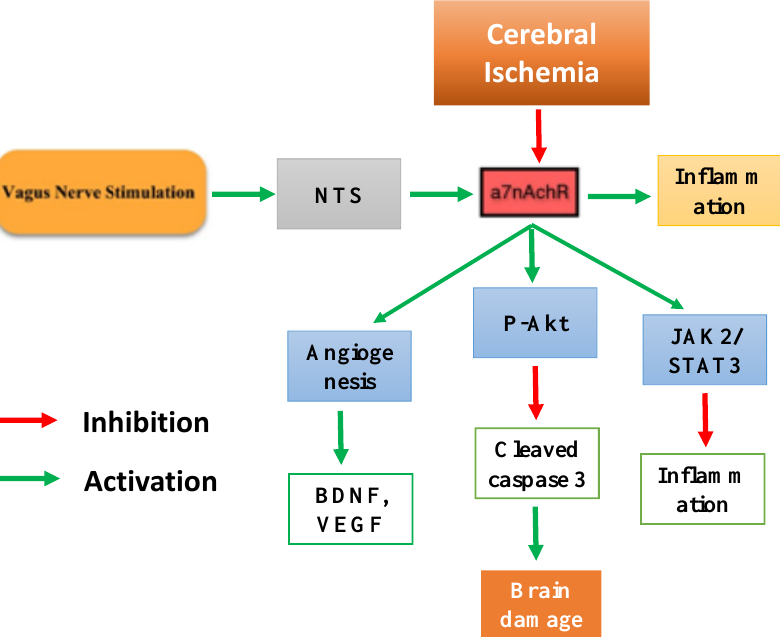
Figure 7. Vagus nerve stimulation has shown to improve stroke with various proposed mechanisms such as anti-apoptosis, angiogenesis and anti-inflammation. NTS — Nucleus of the solitary tract, a7nAChR — a7-nicotinic acetylcholine receptor, BDNF — Brain Derived Neurotrophic Factor, VEGF — Vascular endothelial growth factor, p-Akt — phosphorylated protein kinase B.